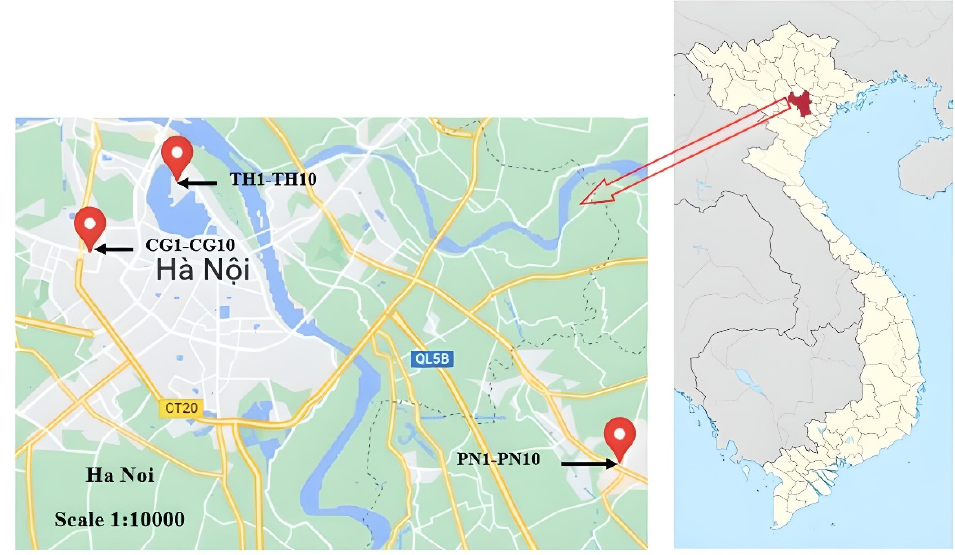
Figure 1. Sampling locations for PM 2.5 dust samples of this study (created by author).